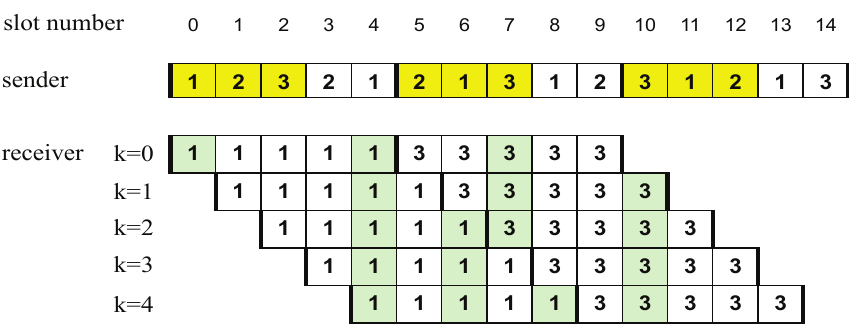
Figure 5. Illustration of FRARS when the number of available channels is